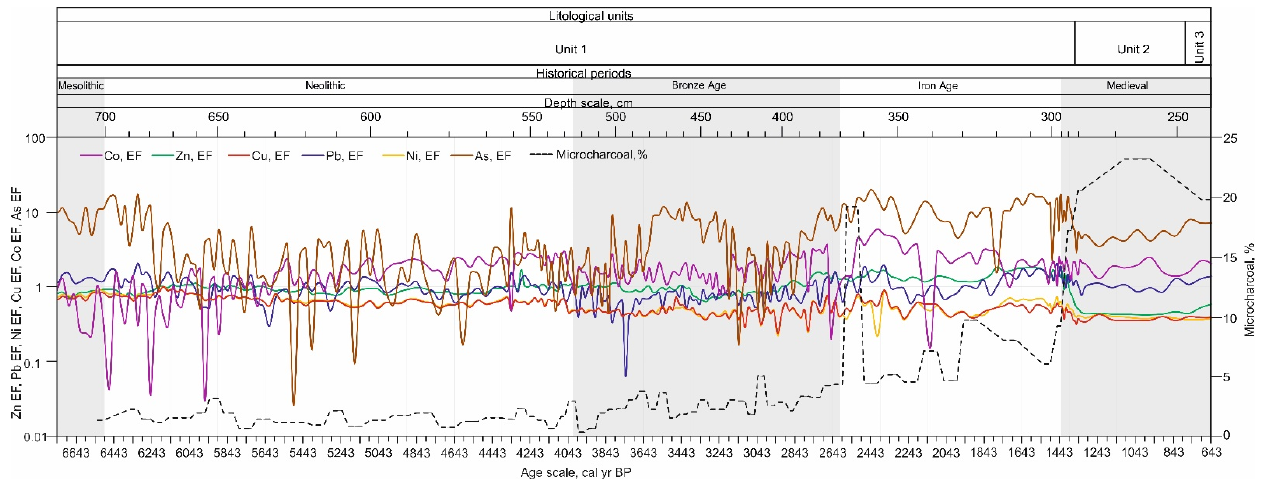
Figure 5. Co, Ni, Zn, Pb, As and Cu enrichment factors (EF) and the microcharcoal concentration in the Kamyshovoe Lake sediments. Modelled age (linear interpolation), cal yr BP.